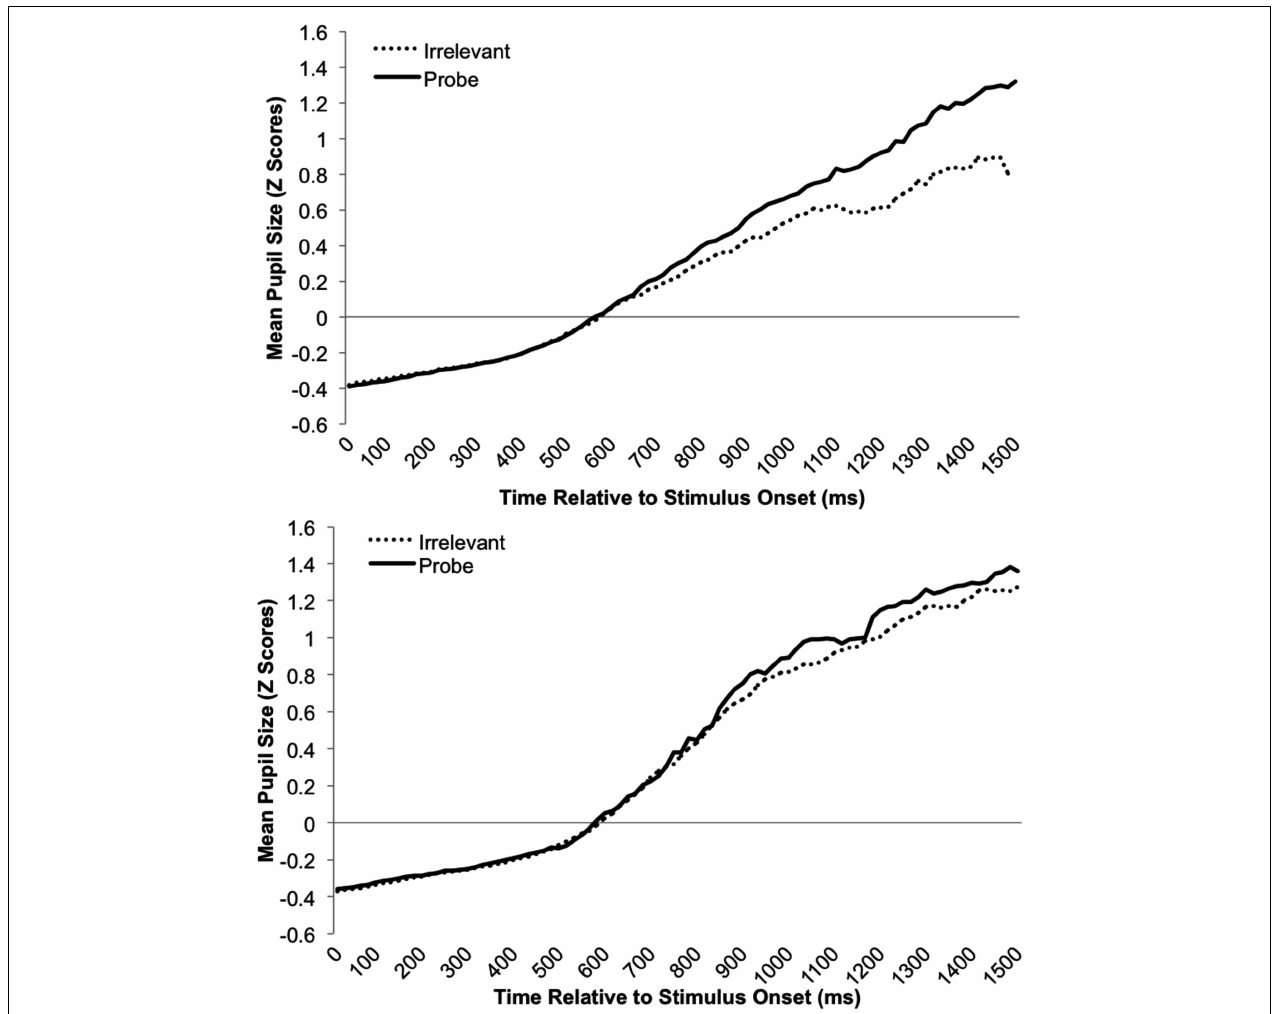
FIGURE 4 | Mean standardized pupil-size data plotted as a function of time (from stimulus onset to 1500ms afterward) and stimulus type for the familiar-probe (top graph) and unfamiliar-probe (bottom graph)